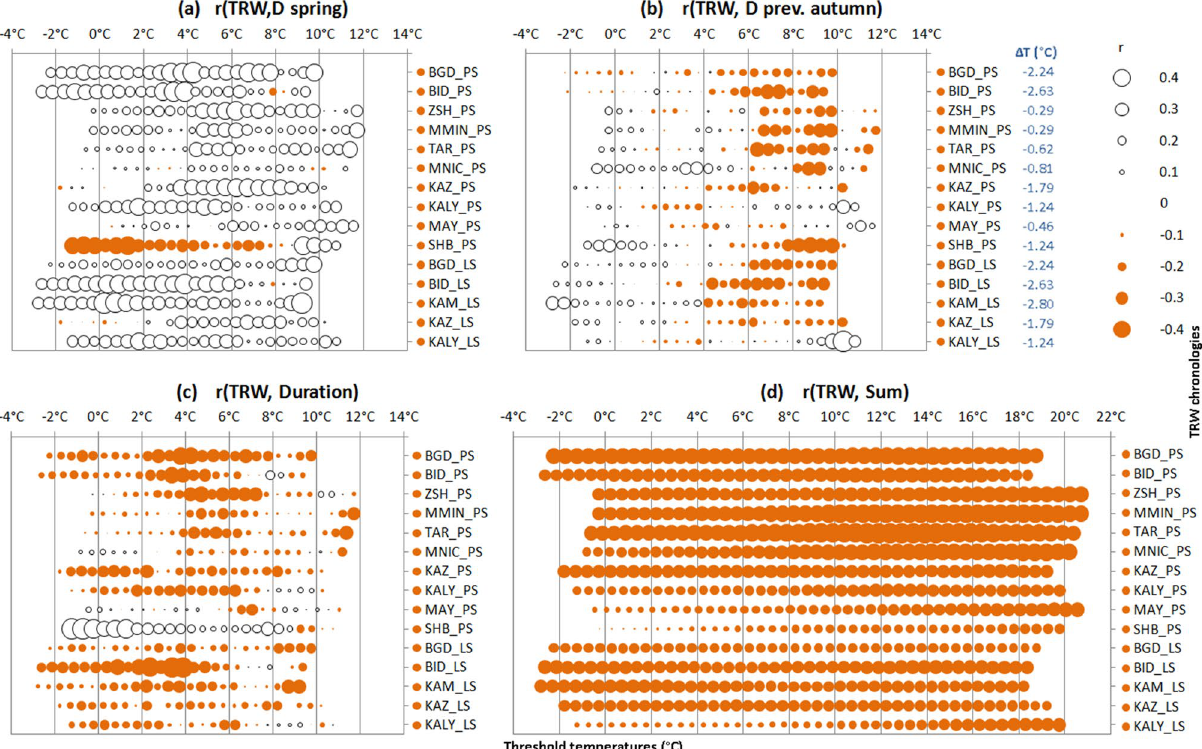
Figure 4. Correlations of TRW chronologies with climatic variables derived from station daily air temperature. ( a ) Date of T crossing threshold temperature values T thr in spring (D spring). ( b ) Date of T crossing T thr in autumn of previous year (D prev. sutumn). ( c ) Duration of period between T crossing T thr in spring and autumn. ( d ) Cumulative temperature sum (degree-days) above T thr . Temperature at sampling sites was corrected from temperature at climate stations as described in “Methods”, temperature correction values are presented near legend